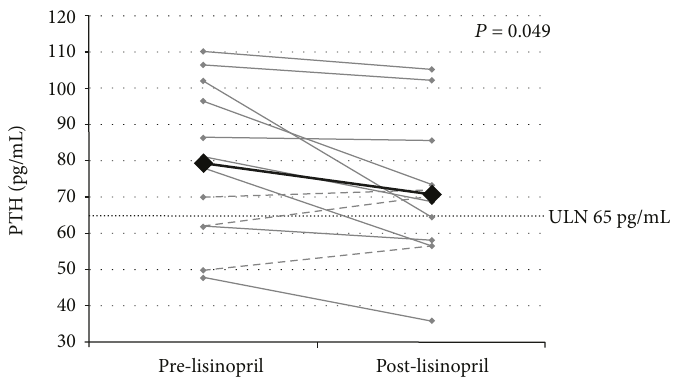
Figure 2: Change in PTH levels with lisinopril in primary HPT participants. Grey lines: participants with lower PTH post-lisinopril. Dashed grey lines: participants with higher PTH post-lisinopril. Black line: mean PTH. PTH, parathyroid hormone; HPT, hyperparathyroidism; ULN, upper limit of